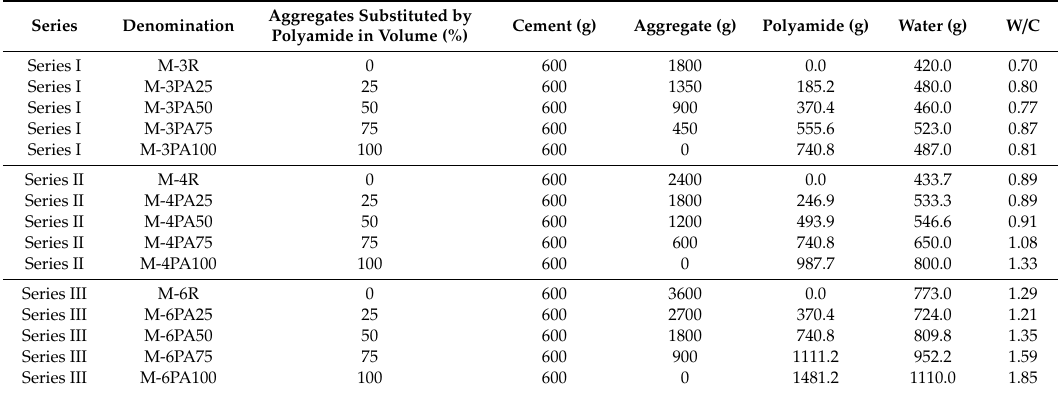
Table 7. Dosages in weight of the raw materials for each mortar.